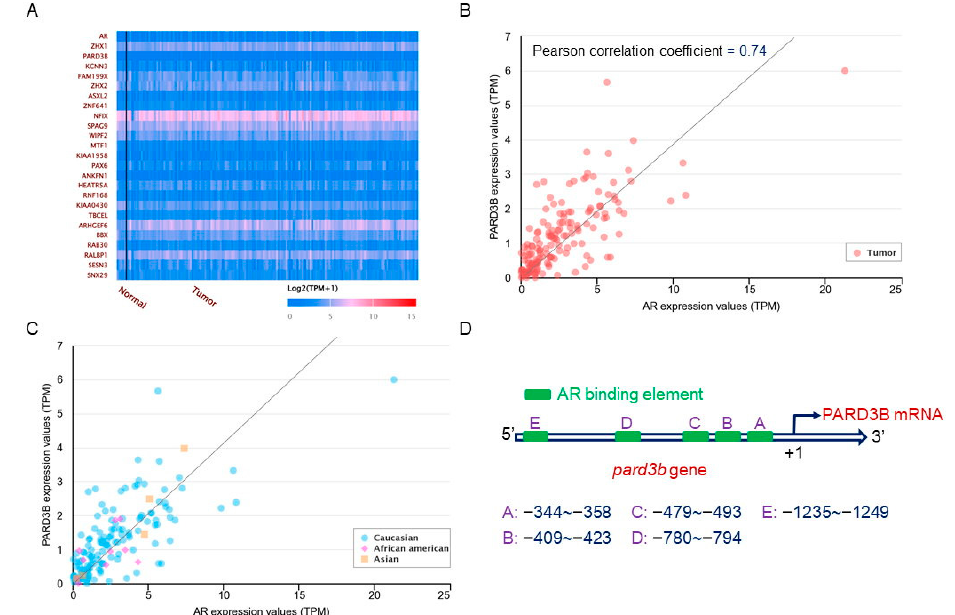
Figure 3. Positive correlation between expressions of androgen receptor ( AR ) and PARD3B genes in glioblastoma multiforme (GBM) tissues. A heatmap shows 25 genes that were positively correlated with the AR in GBM ( A ). Correlations between expressions of the AR and PARD3B genes in GBM tissues ( n = 157) are shown ( B ). Expression correlations of the AR and PARD3B genes in GBM among Caucasian, African American, and Asian populations were further analyzed ( C ). A bioinformatics search showed that five AR-binding elements were predicted in the 5 ′ promoter region of the PARD3B gene ( D ).